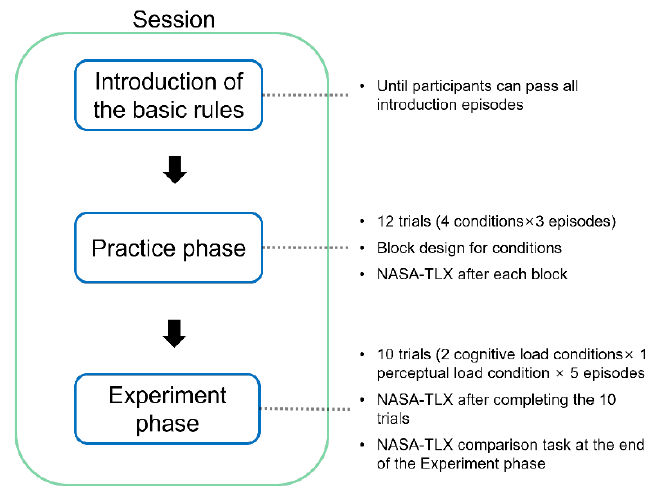
Figure 5. The procedure of one session in the